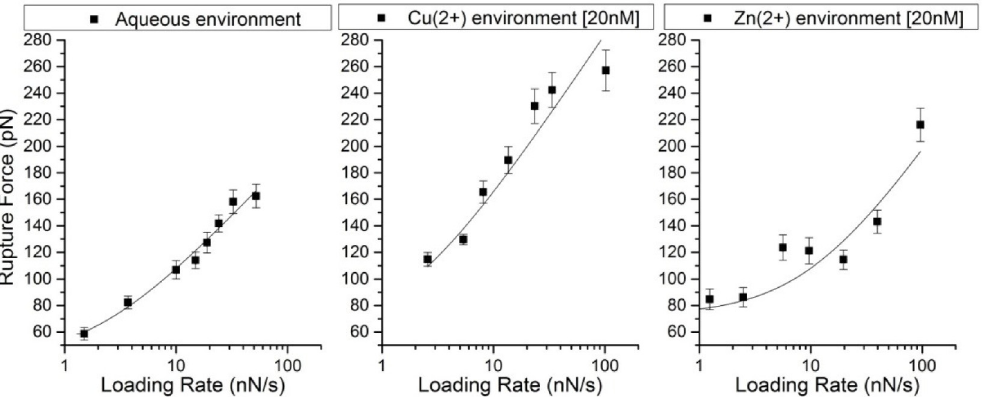
Fig 2. Force vs loading rate plots for A β 42 dimer dissociation in aqueous, Cu 2+ [20nM], and Zn 2+ [20nM] environments. The force plots have been fit with the Friddle-De Yoreo reversible binding model [34]. Adjusted R 2 values of fits are 0.979, 0.897, and 0.808 for aqueous, copper, and zinc data,